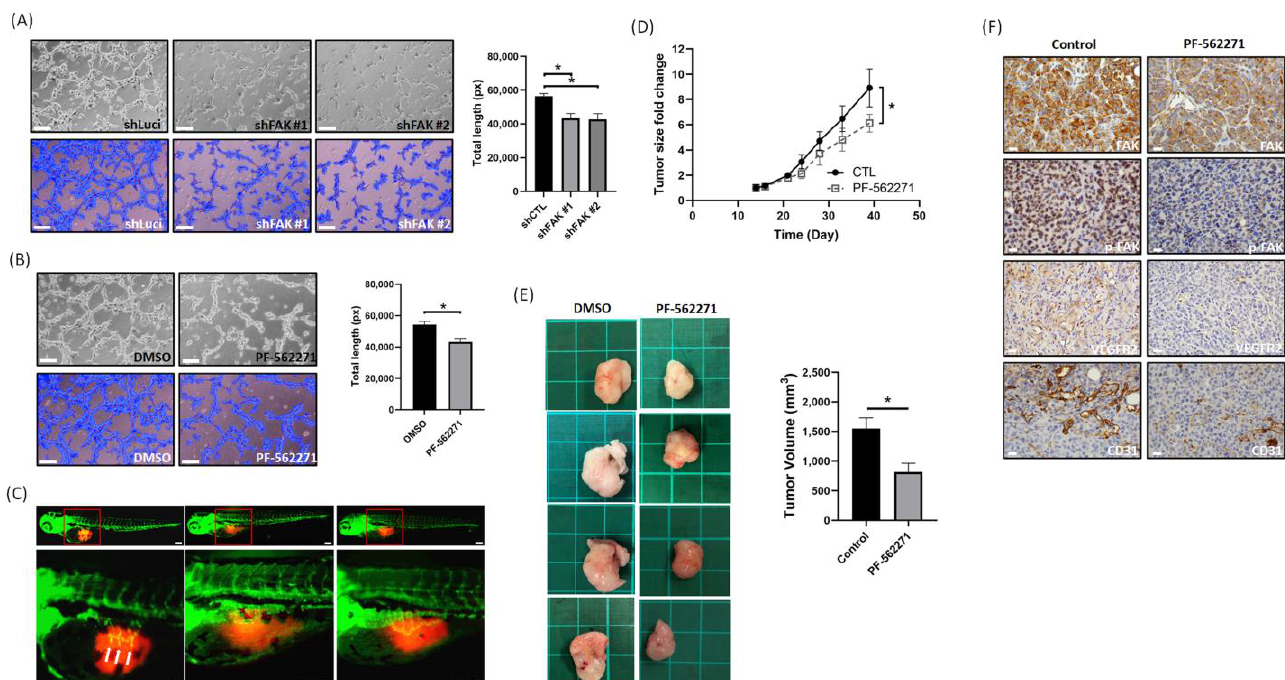
Figure 5. Suppression of FAK affects TNBC cell angiogenesis and tumor growth in vitro and in vivo. ( A ) Representative images of tube formation in HUVECs treated with CM derived from shLuci MDA-MB-231 cells and shFAK MDA-MB-231 cells. Scale bar: 100 µ m. ( B ) Representative images of tube formation in HUVECs treated with CM derived from MDA-MB-231 cells and PF-562271 treated MDA-MB-231 cells. Scale bar: 100 µ m. ( C ) The sprouts originating from the subintestinal venous plexus in the embryos (the white arrow pointed position) of zebrafish showed that shLuci MDA-MB-231 cells induced tumor angiogenesis, but this was suppressed in shFAK MDA-MB-231 cells. Scale bar: 100 µ m. ( D ) PF-562271 suppressed tumor growth in MDA-MB-231 xenograft mice model ( n = 4 for each group). ( E ) Tumor volume between vehicle and PF-562271 treated groups. Each tumor was from a different mouse. The bar chart represents the quantification of tumor volume from mice ( n = 4 for each group). Tumor volume in PF-562271 treated group was significantly smaller than in vehicle treated group. ( F ) IHC staining represents FAK, p-FAK(Y397), VEGFR2, and CD31 expressions. The expressions of these proteins were reduced in PF-562271 treated group than vehicle treated group. Scale bar: 20 µ m. *: p < 0.05.